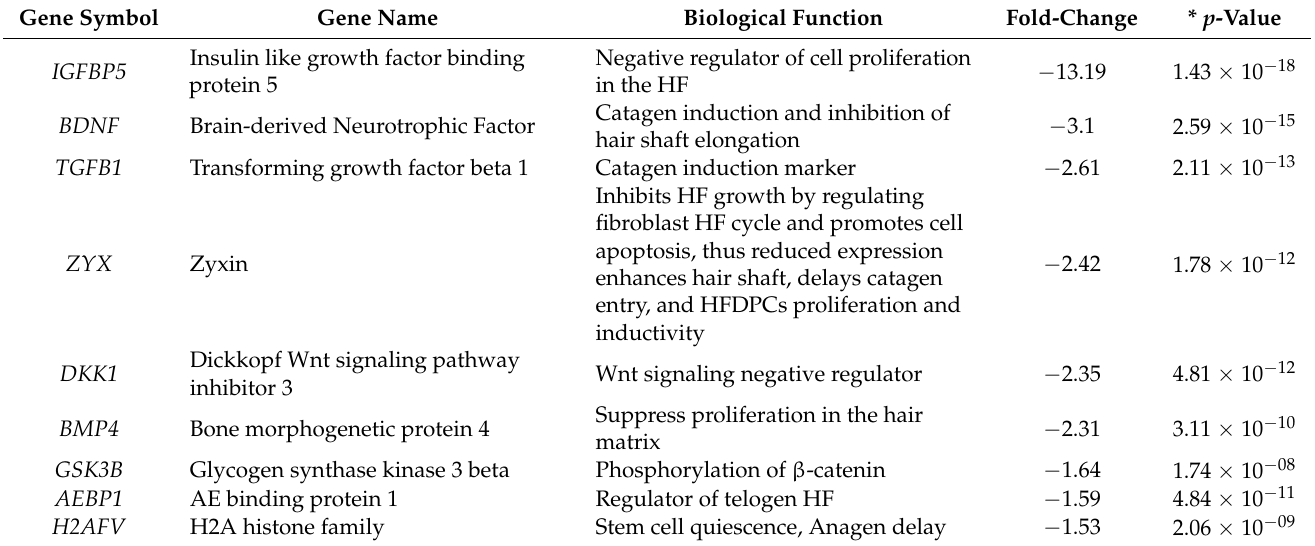
Table 3. Summary of the top downregulated hair growth- associated genes by BT-GC.